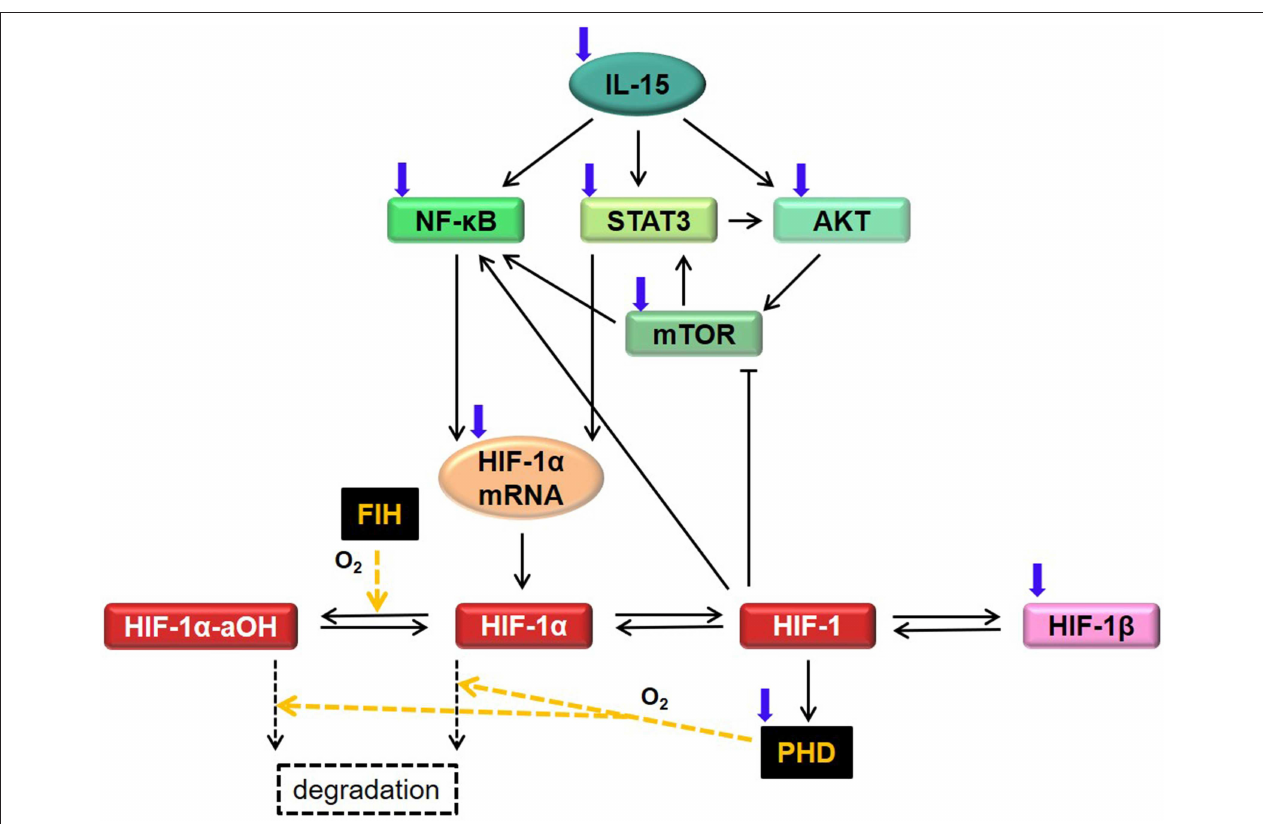
FIGURE 1 | Diagram for HIF-1 α regulatory network in NK cells, corresponding to model Equations (2)–(11). We study the interplay of HIF-1 α , IL-15, mTOR, NF- κ B, and STAT3 in normoxia and hypoxia. A signaling cascade starting with IL-15 activates NF- κ B, STAT3, and AKT. This in turn activates mTOR, influencing HIF-1 α mRNA and HIF-1 α protein levels. In normoxia, HIF-1 α is hydroxylated via FIH and PHD. Here, we consider only the FIH-mediated asparaginyl-hydroxylated HIF-1 α (HIF-1 α -aOH) and assume that a small fraction of HIF-1 α -aOH can be dehydroxylated. In normoxia, hydroxylated HIF-1 α is degraded via Von Hippel-Landau protein (not considered in the model). In hypoxia, HIF-1 α accumulates and binds to HIF-1 β , building the HIF-1 complex. The latter is responsible for both a positive and a negative feedback on HIF-1 α , via activation of NF- κ B and via inhibition of mTOR and upregulation of PHD. Black arrows indicate protein activation, translation or formation/dissociation of protein complexes. For simplicity, basal degradation of molecules is not depicted here. The blind-ended arrow indicates inhibition. Blue arrows indicate external regulation due to further stimuli not specifically considered in the mathematical model. Yellow arrows indicate HIF-1 α hydroxylation via FIH or